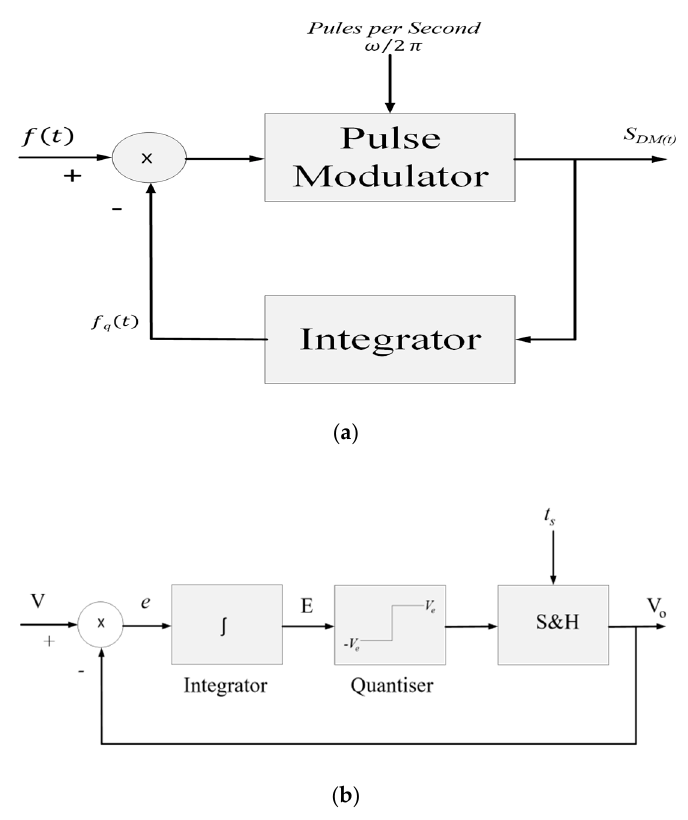
Figure 18. Schematic diagram of delta modulation ( a ) simple delta modulator; diagram of delta modulation ( b ) sigma-delta modulation (SDM).